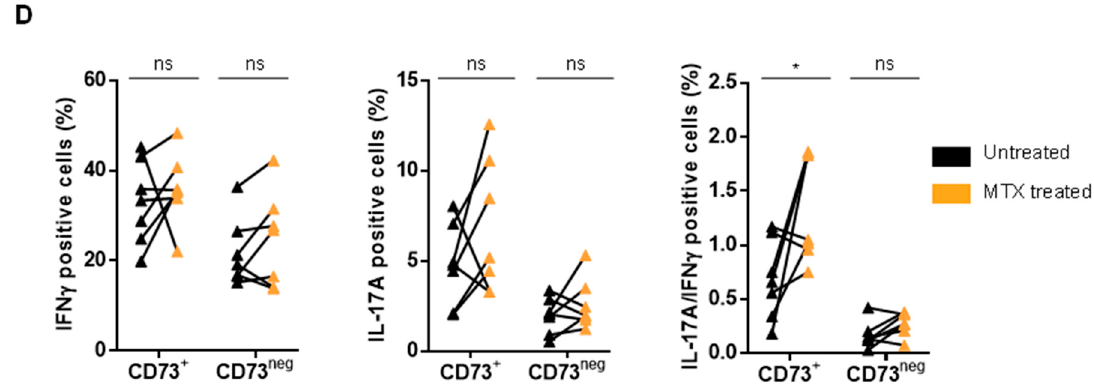
Figure 4. Impact of MTX treatment on Teff polyfunctionality . ( A , B ). Analysis of CD73 expression on cytokine secreting Teff mirrors phenotypic analysis in RA ( A ) and PsA ( B ) patients. ( C , D ). IFN- γ , IL-17A producing and IFN- γ /IL-17A co-producers in RA ( n = 4) ( C ) and PsA ( n = 7) ( D ) patients before initiation of MTX treatment and under MTX treatment. A , B : Mann-Whitney tests, C , D : ANOVA-2 paired samples * p < 0.05, ** p < 0.001.